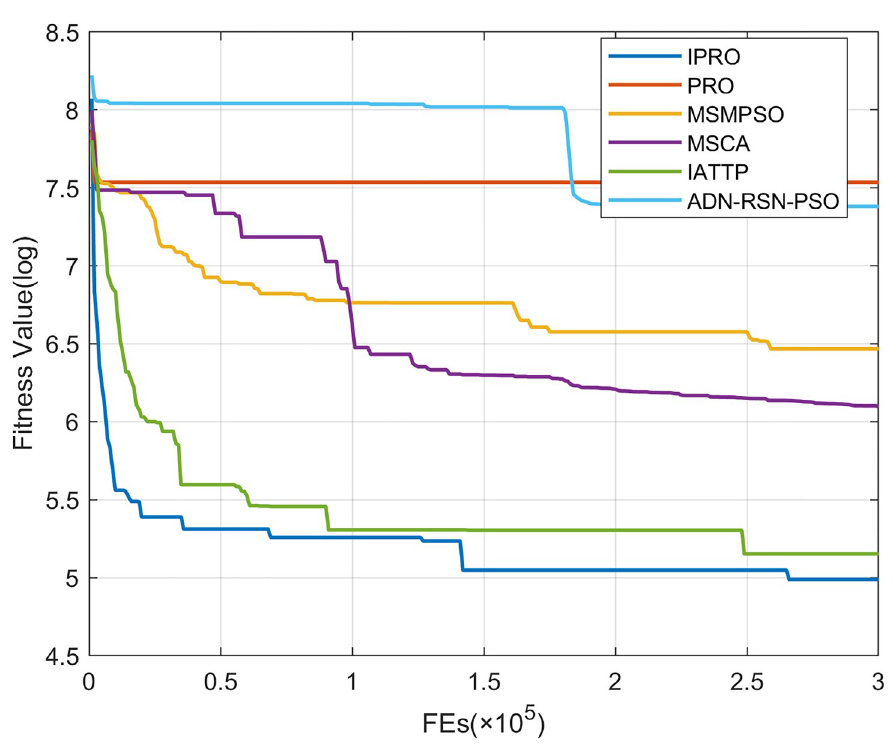
Fig 18. Convergence curves on